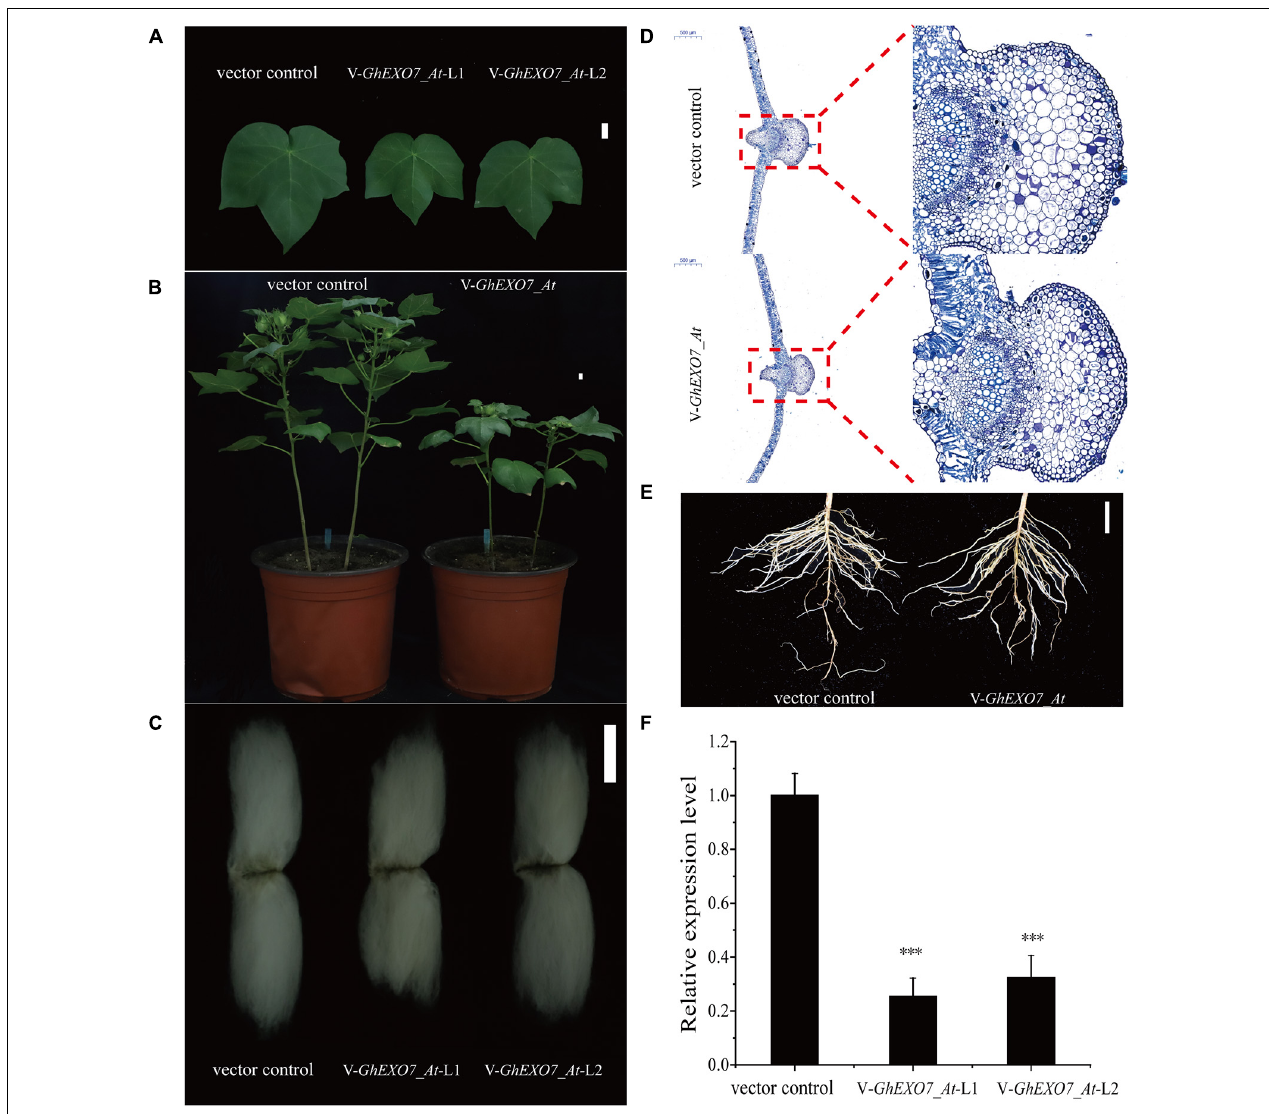
FIGURE 8 | Virus-induced gene silencing (VIGS) of GhEXO7_At in cotton. (A) Phenotypes of leaves of the vector control and VIGS: GhEXO7_At plants. Scale bars = 1 cm. (B) Plant architecture of the vector control and VIGS: GhEXO7_At plants. Scale bars = 1 cm. (C) Fibers produced by the vector control and VIGS: GhEXO7_At plants. Scale bar = 1 cm. (D) Comparison of cells size from the fourth leaf of vector control and VIGS: GhEXO7_At plants. (E) The root phenotypes of vector control and VIGS: GhEXO7_At plants grown 30 days in the greenhouse. (F) Relative expression levels of the GhEXO7_At gene in the vector control and VIGS: GhEXO7_At plants. Student’s t -test: ∗∗∗ p <